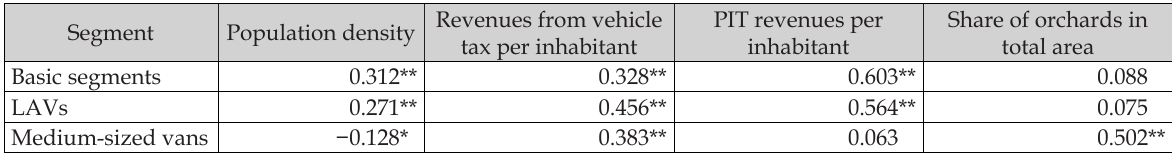
Table 2. Correlation coefficients between the number of LGVs (permissible load capacity <1.5 tonnes) per 1,000 inhabitants by their segments and selected socio-economic features.